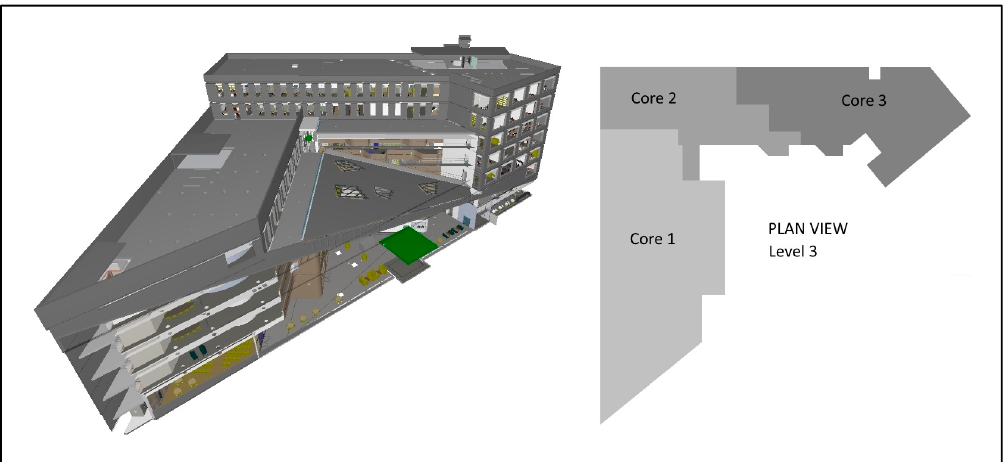
Figure 4. A 3D architectural IFC model of the Urban Sciences Building, Newcastle upon Tyne, UK, and a plan view of the electrical supply zoning layout for the third floor.